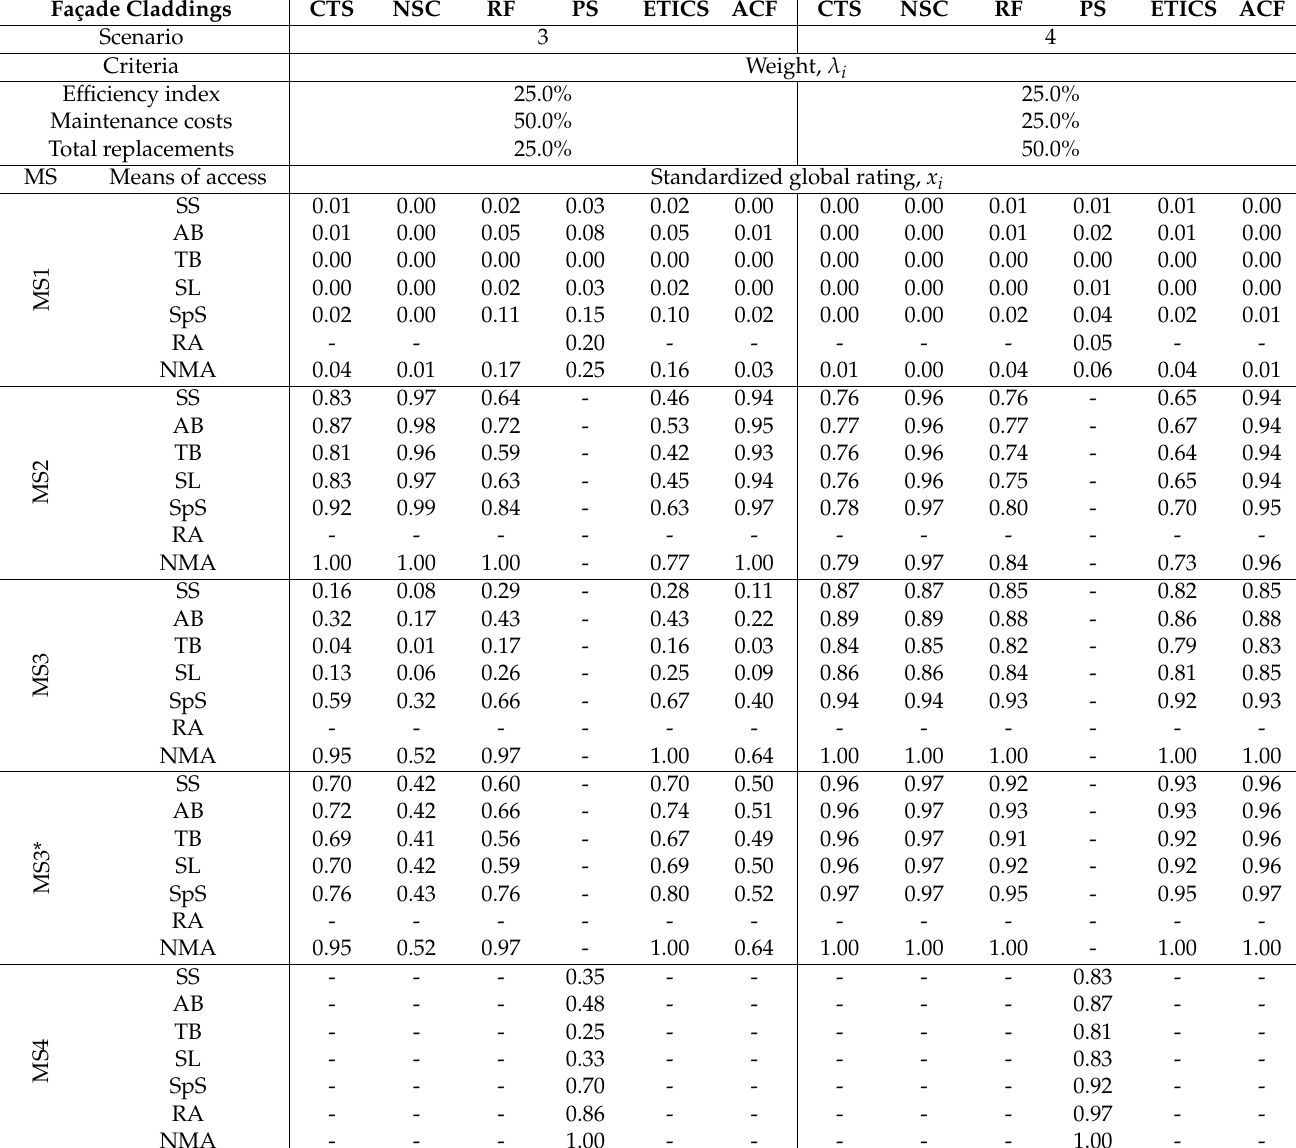
Table 4. Multi-criteria analysis